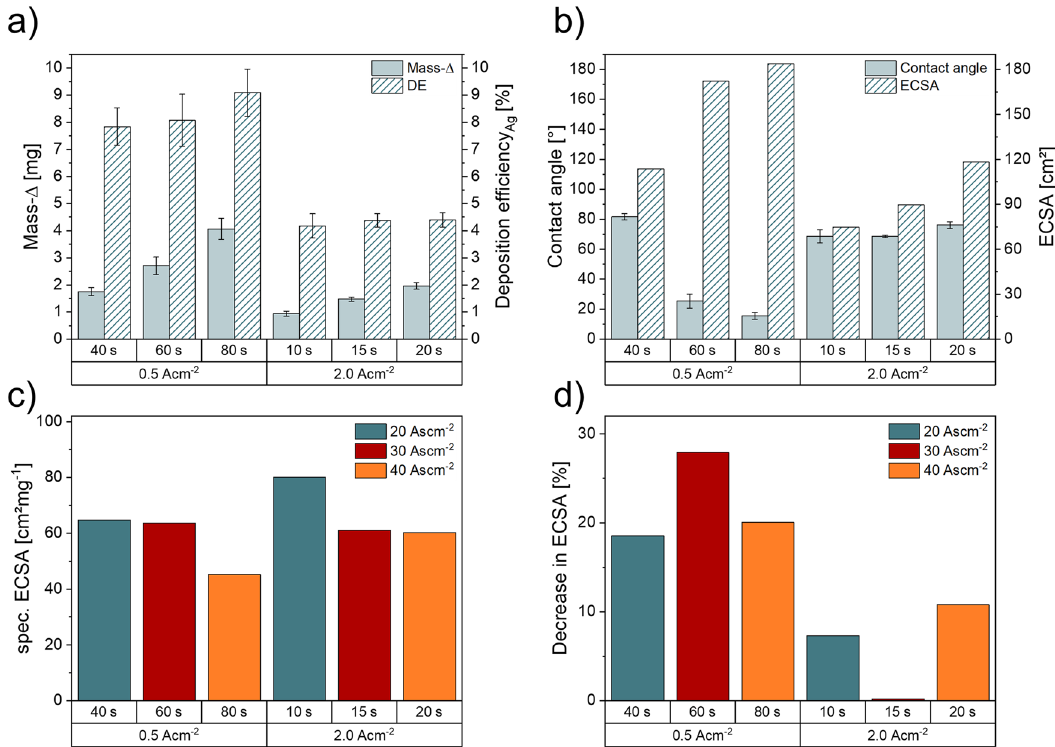
Fig. 2 In fl uence of the applied DHBT parameters on the deposited silver mass, deposition ef fi ciency, surface contact angle and resulting electrochemical surface area. Mass-increase and Ag deposition ef fi ciency of Dynamic Hydrogen Bubble Templation method ( a ), contact angle and absolute values of the electrochemical surface area (ECSA) of all tested samples ( b ), the resulting speci fi c ECSA ( c ) and the decrease in ECSA after 1 h of CO 2 RR at each tested potential ( d ). Error bars correspond to the average of at least two individual measurements on two different